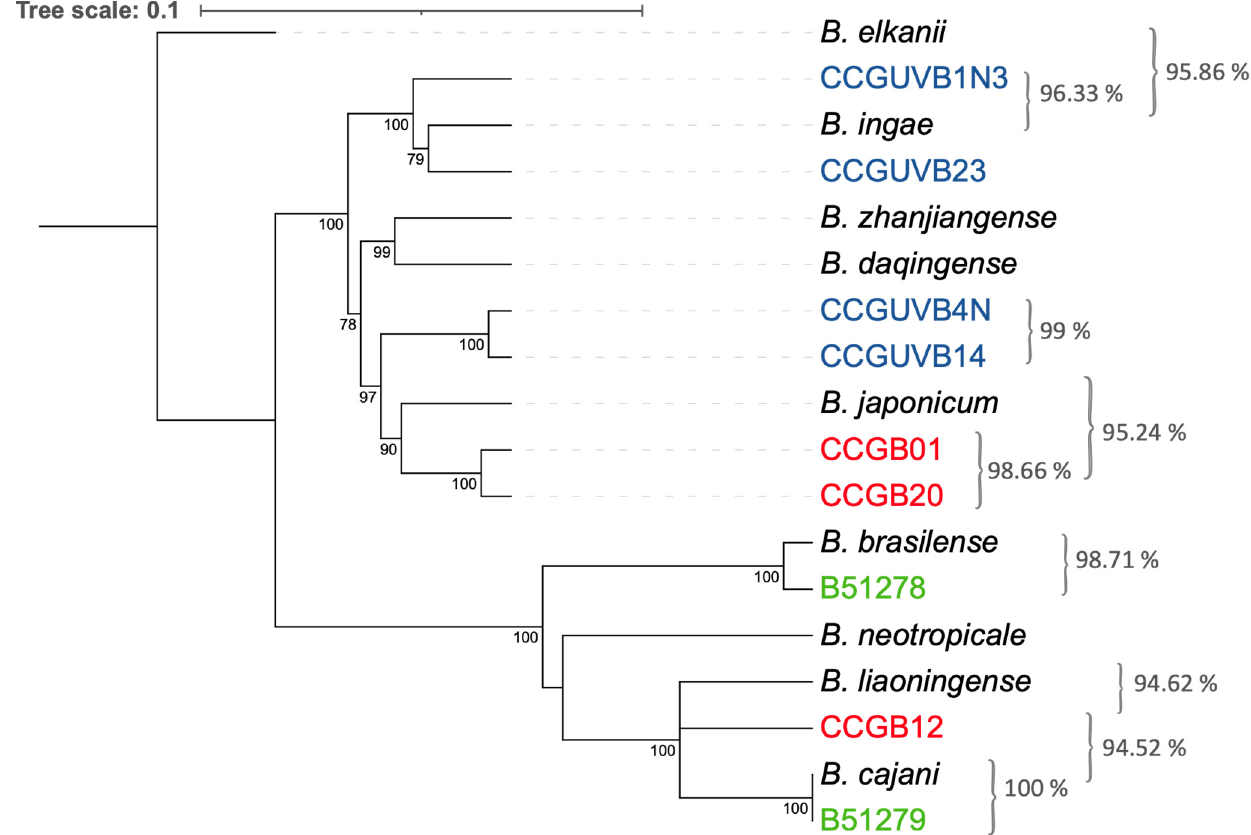
Figure 3. Maximum-likelihood phylogenetic tree based on glnII , rpoB , recA and gyrB gene sequences of Mexican Inga vera and Lysiloma isolates. Concatenate alignment length 2013 bp: glnII (537 bp), gyrB (621 bp), recA (420 bp) and gyrB (525 bp). Substitution model was GTR+F+I+G4. Bootstrap values lower than 70% are not shown. B. elkanii USDA76(T) was used as an external group. Bar, substitutions per site. Blue for I. vera isolates, red for Lysiloma sp. isolates, green for L. divaricatum isolates. The average nucleotide identity (ANI) of these genes (%), within and between groups is indicated. The species tree was inferred from 1133 orthogroups, with 95% of species having single-copy genes in any orthogroup, and the consensus tree was created from 21,907 gene trees (Figure 4). The orthologous species consensus tree showed that B51278 clustered with B. brasilense and strain B51279 with B. cajani ; this clustering was also seen in the 16S rRNA and glnII phylogenetic trees. Lysiloma CCGB01 and CCGB20 strains clustered together, and the Inga CCGUVB14 and CCGUVB4N were also